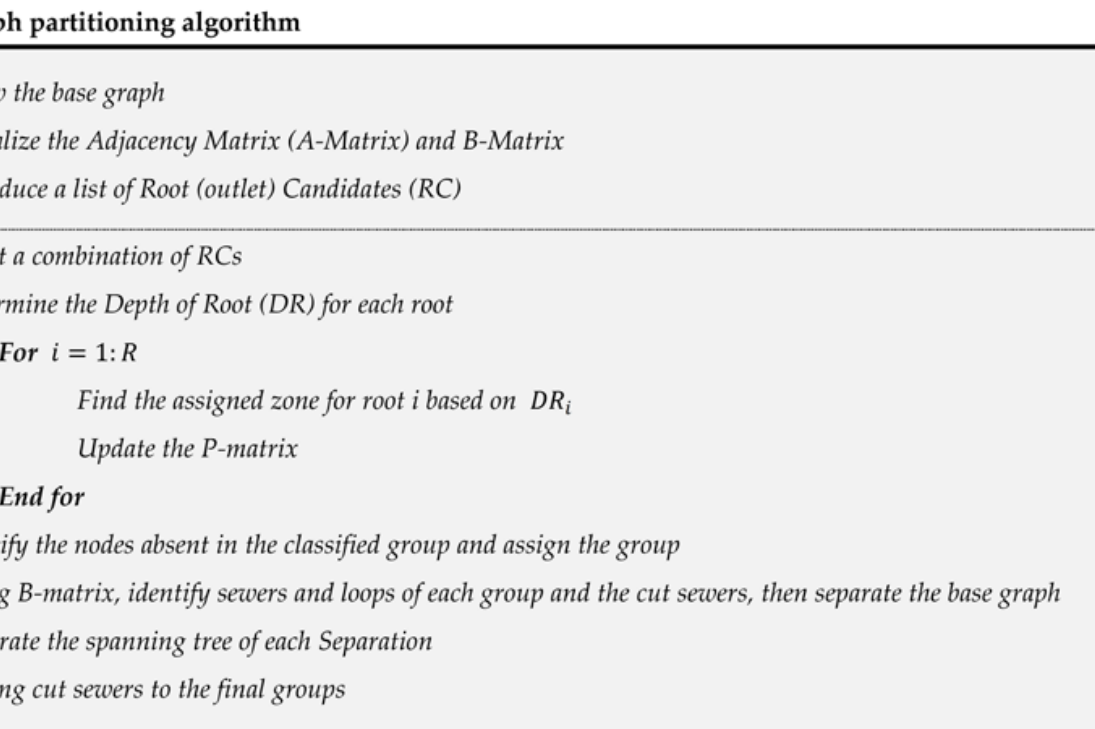
Figure 1. Pseudocode of the decentralized layout generation algorithm.